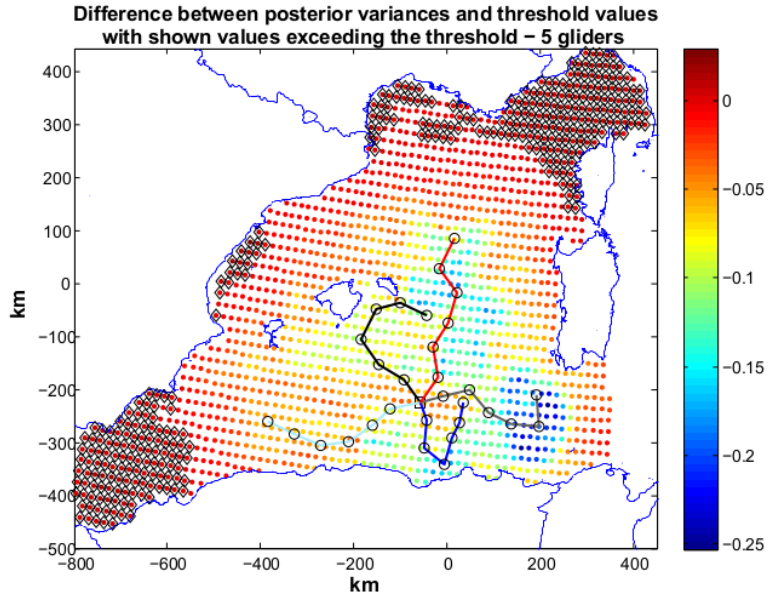
Figure 9. Scenario 3: planned paths for five gliders. The solution is characterized by J η = 1.67 ( J c = 2). In the figure we show also the difference between posterior variances and relative values of the objective threshold. The high number of black markers toward the north-east and south-west parts of the operative area indicates posteriors for which gliders did not succeed in reducing enough failing to meet the target variance. More samplings (gliders) are therefore needed.